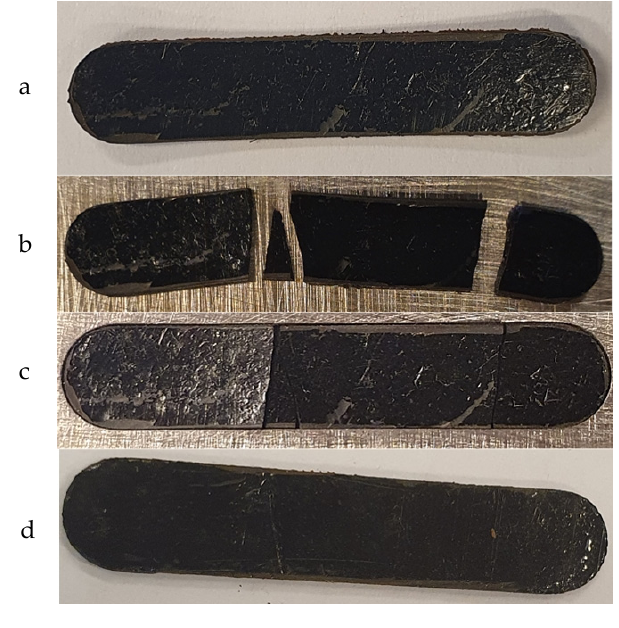
Figure 12. Bar of PKFUBISM containing the 2.7 wt% of rGO after molding ( a ), breaking ( b ), inside the mold ( c ) and after self-healing ( d ). Bar size: 45 mm long, 5 mm wide and 1 mm thick.